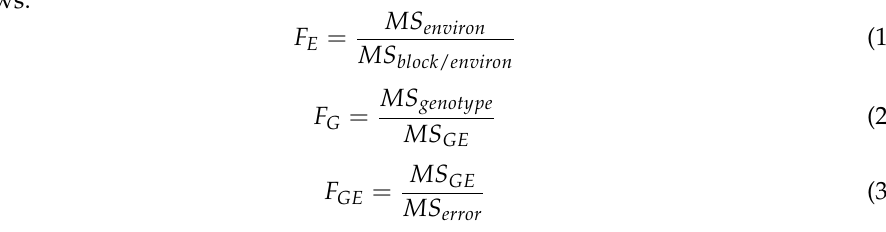
Table 3. Expected mean square (EMS) table listing sources of variation (SOV), associated degrees of freedom (DF), and components of the variation for the analysis of nutrient traits in cowpea leaves. SOV DF MS EMS Environment (E) e − 1 MS environ V error + gV B/E + rgV environ Block/E e(r − 1) MS block/environ V error + gV B/E Genotype (G) g − 1 MS genotype V error + rV GE + reV genotype GE (g − 1)(e − 1) MS GE V error + rV GE Error (g − 1)(r − 1)e MS error V error Total gre − 1 SOV = sources of variation; DF = degree of freedom; MS = mean squares; EMS = error mean